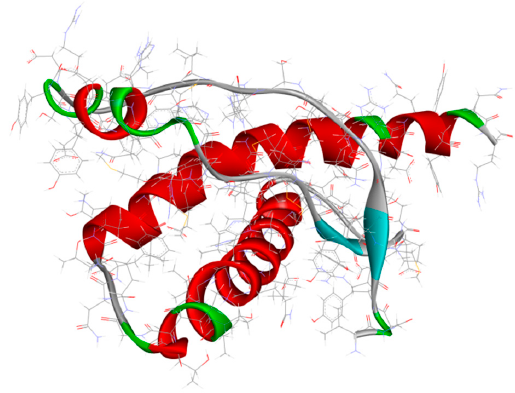
Figure 6. Structure of human prion protein fragment (PDB code: 1QM1) [144].